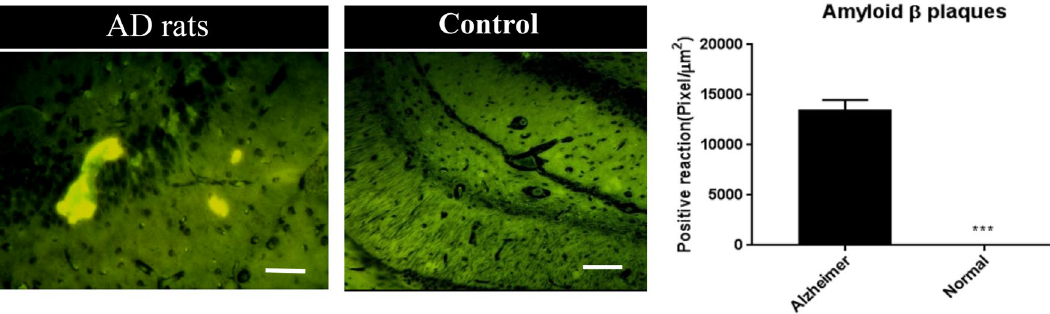
Figure 1. Photomicrographs of thioflavin staining to assess beta-amyloid plaques in the hippocampus of control and Alzheimer’s rats. After confirming Alzheimer’s model in animals, the rats were randomly assigned in to two groups (A-C and A-Ex). Scale bar = 50 µm. *** p < 0.0001.